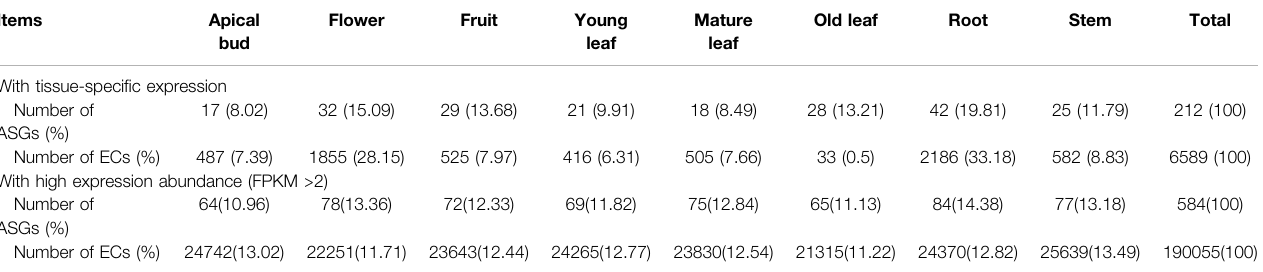
TABLE 2 | Tissue expression pattern of camellia -speci fi c genes (CSGs) and evolutionary conserved genes (ECs). Items Apical bud With tissue-speci fi c expression Number